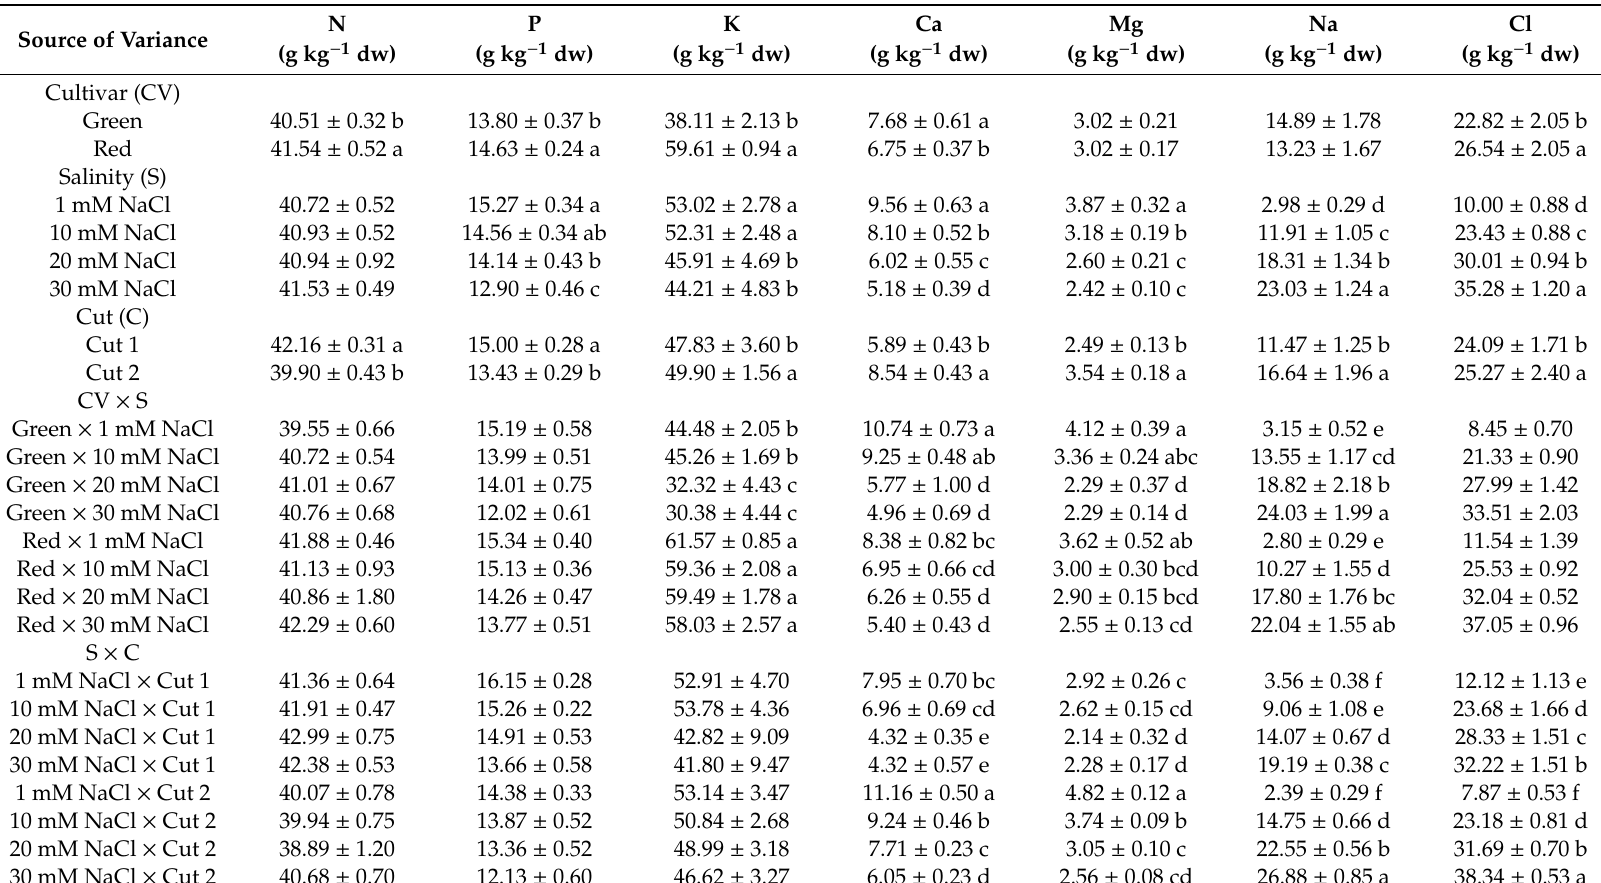
Table 2. Significance of the main factors (cultivar, salinity and cut order) and their interactions on leaf mineral composition (total nitrogen [N], phosphorus [P], potassium [K], calcium [Ca], magnesium [Mg], sodium [Na], chloride [Cl]) of Lactuca sativa L. var. acephala grown in a floating raft